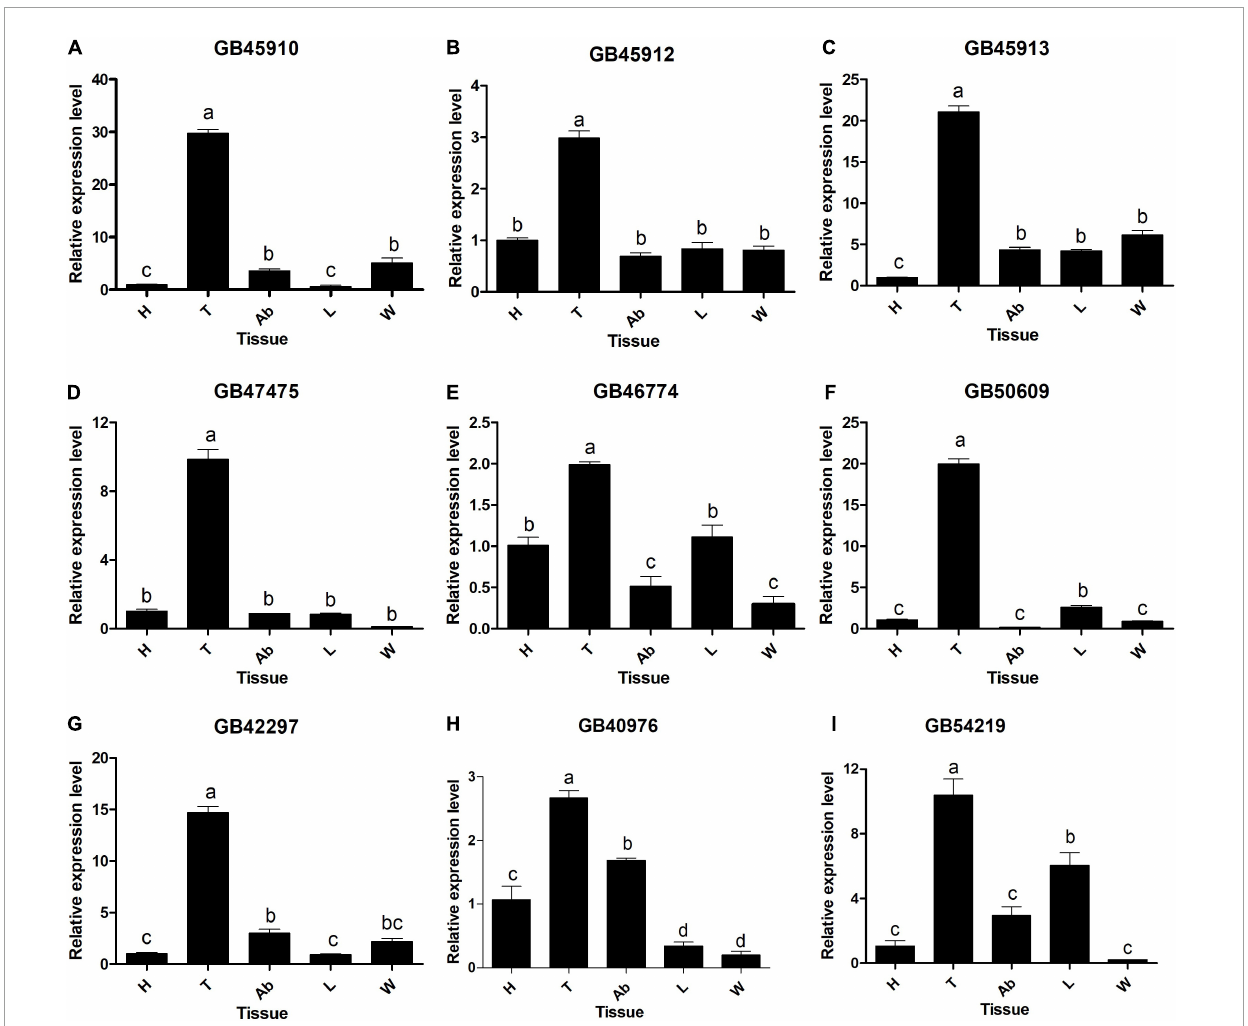
FIGURE7 Relative expression levels of DEGs in different tissues. (A) GB45910. (B) GB45912. (C) GB45913. (D) GB47475. (E) GB46774. (F) GB50609. (G) GB42297. (H) GB40976. (I) GB54219. H, head without antenna; Ab, abdomen; T, thorax without wings; L, legs; W, wings. Different capital letters indicate significant differences between tissues at the 0.05 level. Data are presented as mean ±